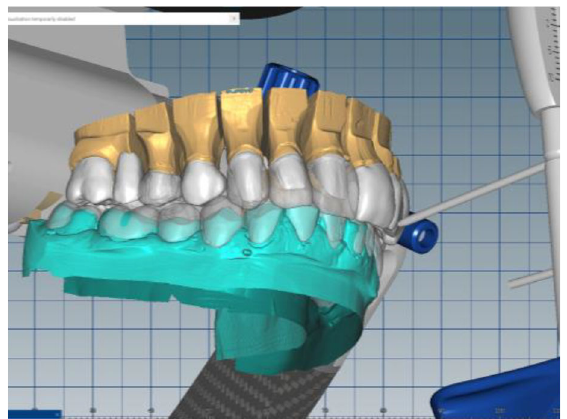
Figure 7. Digital design – crowns.